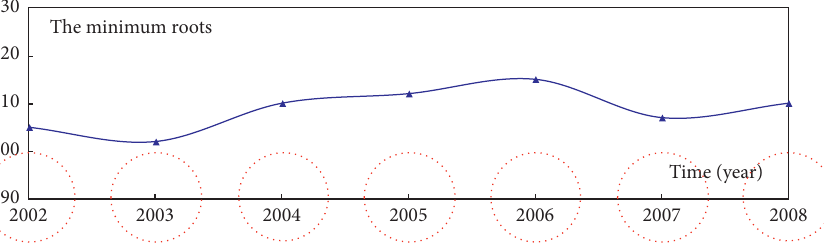
Figure 10: Variation curve of the minimum roots with